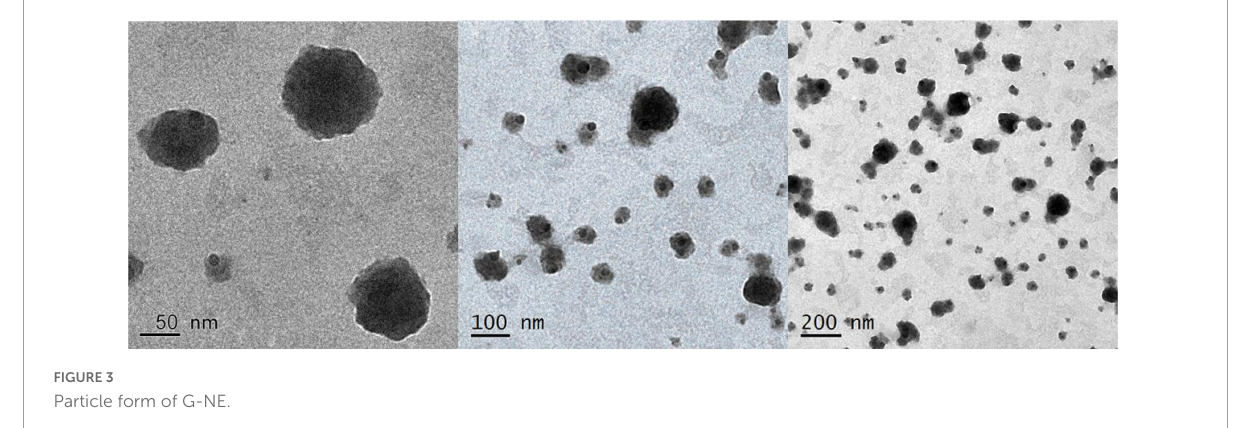
FIGURE3 Particle form of G-NE.